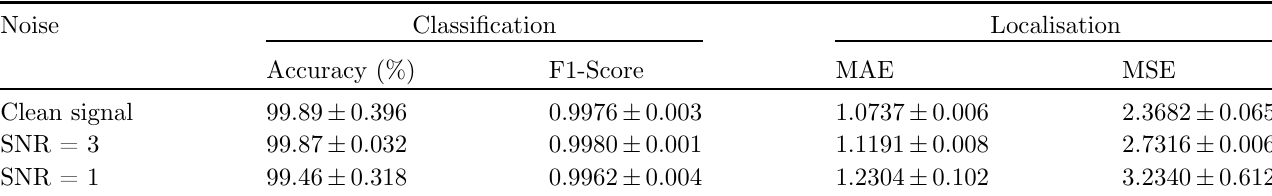
Table 4. Localisation of the coordinates of a vibrating fuel assembly ( i, j ), in the time-domain utilising the proposed LSTM architecture, under input signal corruption. Mean and standard deviation of 3